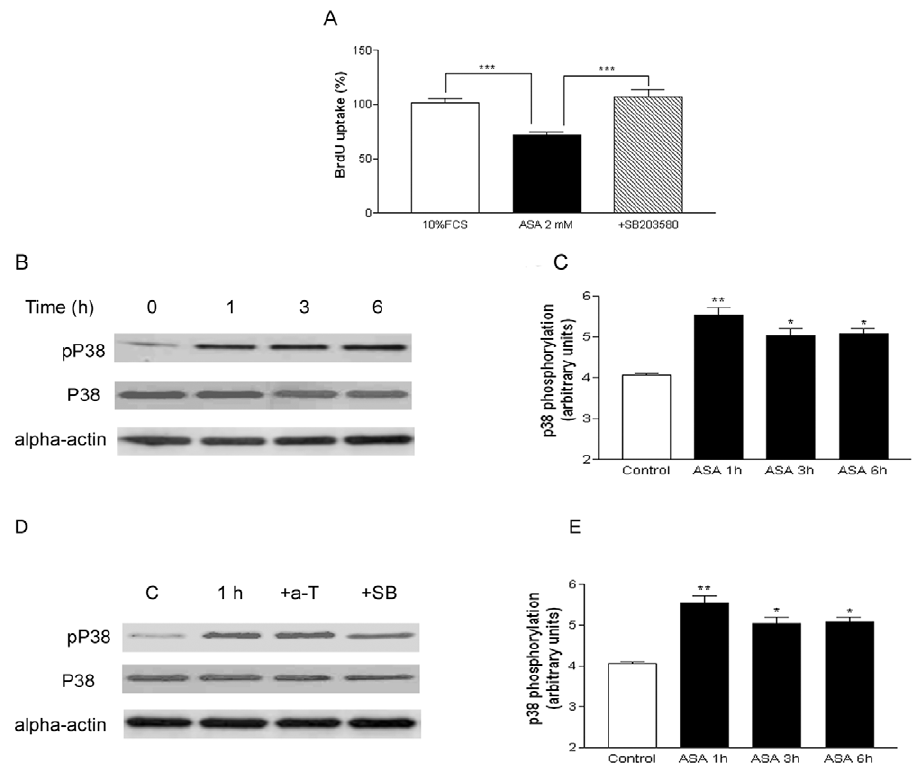
Figure 4. The p38 MAPK pathway is involved in the antiproliferative effect of ASA. Panel A: The p38 MAPK inhibitor SB203580 (10 m M) reversed the antiproliferative effect of ASA (2 mM). Panel B: Representative blots of p38 MAPK phosphorylation after ASA incubation (2 mM) at several time-points. Panel C: quantification of pooled Western blot experiments. Panel D: Representative blots show the role of the TGF- b pathway inhibitors anti-TGF- b 1 antibody (50 m g/ml) and SB-431542 (10 m M) on ASA-induced p38 MAPK phosphorylation, Panel E: quantification of pooled Western blot experiments. a-T= anti-TGF- b 1 antibody, SB= SB-431542. Bar graphs show the mean 6 S.E.M of n=4 experiments (cell cultures from 4 different patients). * P , 0.05, ** P , 0.01, *** P , 0.001.